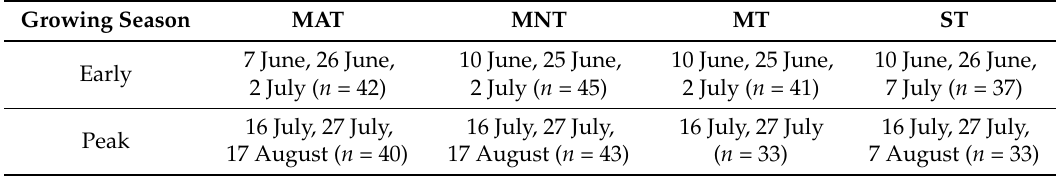
Table 2. Sampling dates and total number of observations per vegetation community during the